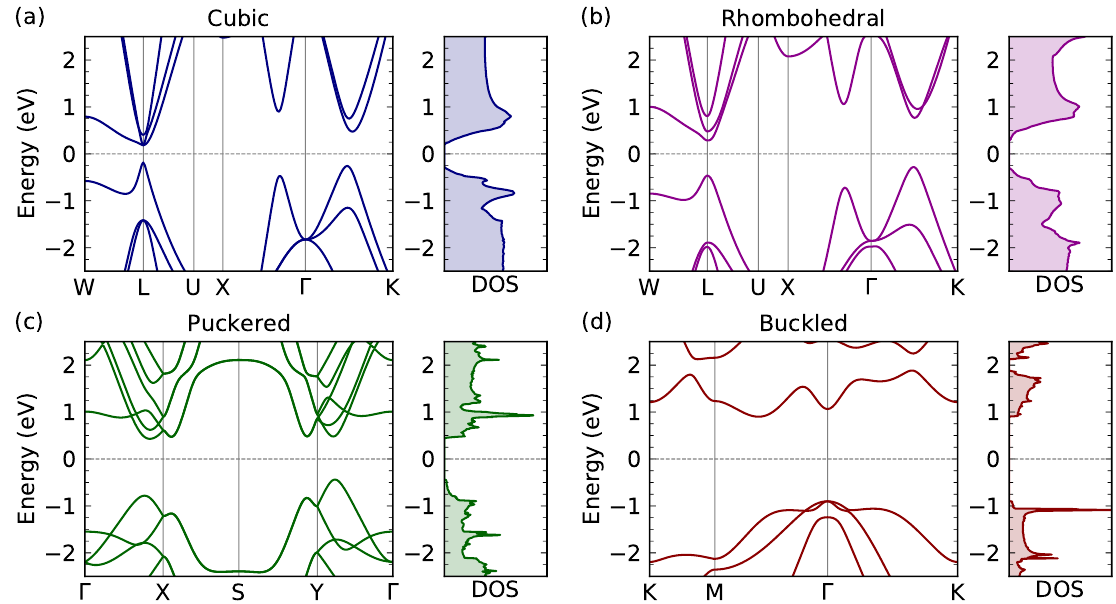
Figure 2. Energy dispersion and density of states (DOS) of ( a ) bulk cubic, ( b ) bulk rhombohedral, ( c ) puckered monolayer, and ( d ) buckled monolayer GeTe. The DOS is expressed in arbitrary units for clarity since we do not need the details of the number of states per